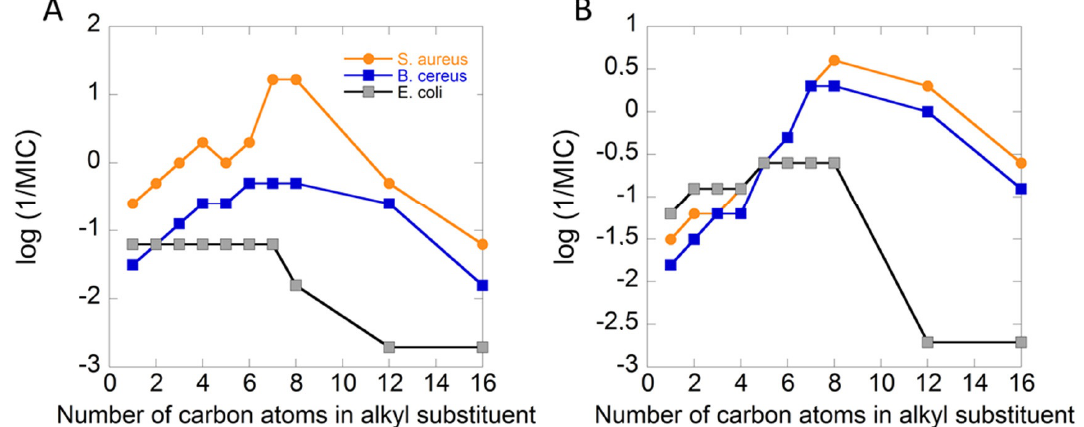
Figure 3. The relationship between the activity (in the log (1/MIC)) of the imidazolium salts against bacterial species and the number of carbon atoms in the alkyl chain (( A ): the salts 3a-j , ( B ): the salts 4a-j ).